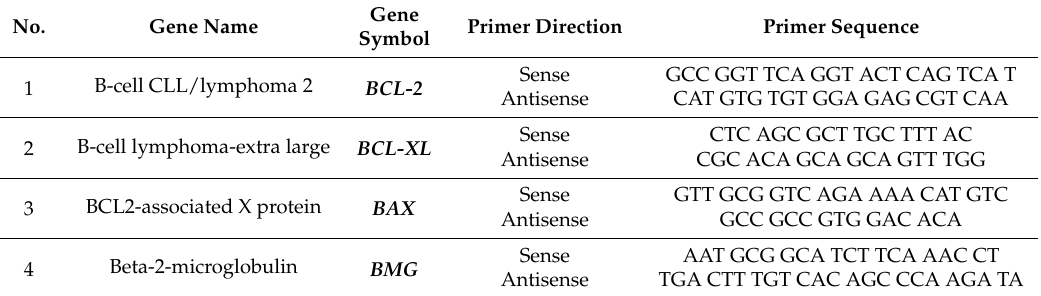
Table 6. List of primers used in this